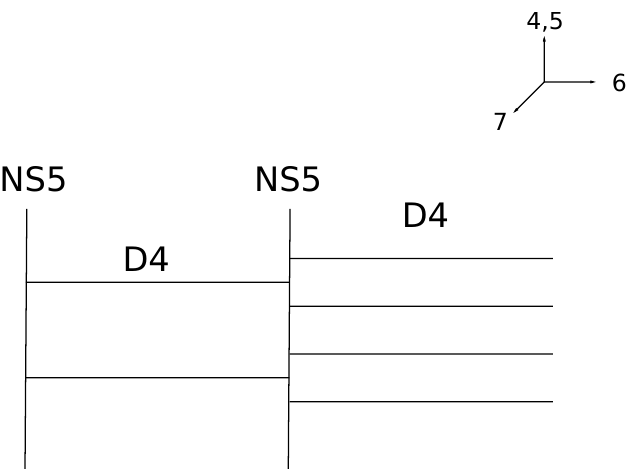
Figure 2 . A brane construction for SU(2) with N f = 4 , where all the four semi-infinite D4-branes end on one NS5-brane. This brane construction corresponds to the asymmetric setup discussed in section